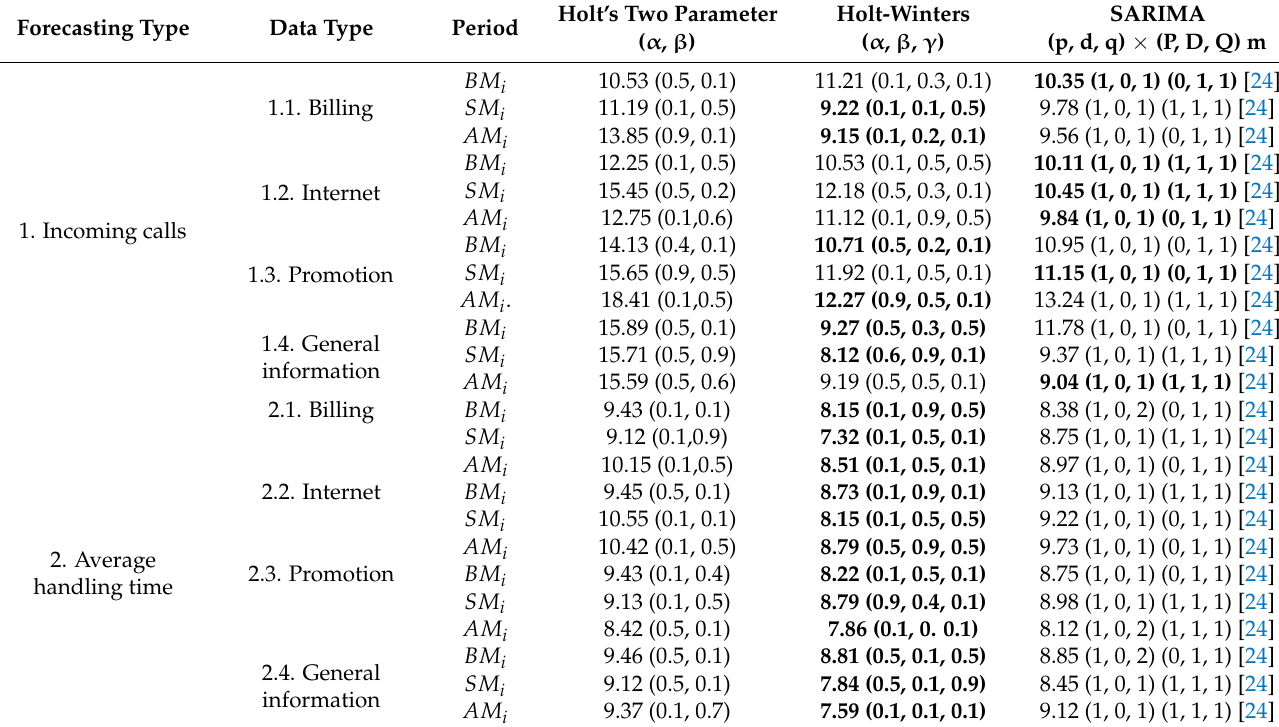
Table 13. Comparison of the MAPEs for data type 1 during a new mobile phone event.